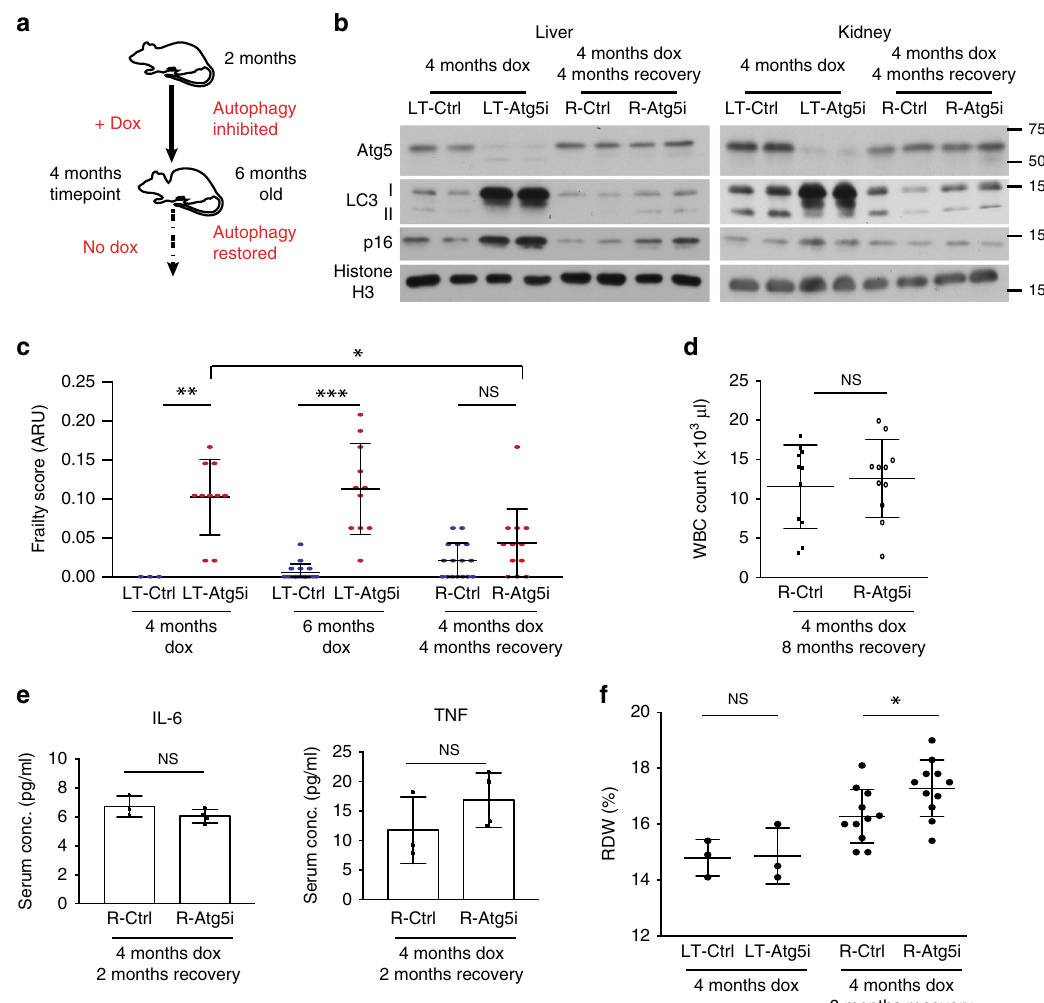
Fig. 4 Restoration of autophagy partially restores health-span. a Schematic of R-Atg5i study. Brie fl y 2-month old mice are given dox to induce Atg5 downregulation for 4 months at which point they exhibit ageing-like phenotypes. Dox is then removed and autophagy restored. b Liver and kidney tissues from R-Atg5i mice with autophagy restored for 4 months display evidence of Atg5 protein and autophagic fl ux restoration, yet the liver still stains positively for the marker of senescence p16. c Atg5i mice on dox for 4 months and 6 months display increase frailty scores in comparison with controls (ARU, arbitrary units). While R-Atg5i mice where autophagy has been restored for 4 months, display a recovery (Two-way ANOVA with Tukey ’ s correction for all comparisons, n = 3 – 16). d Whole blood cell counts from R-Atg5i mice display no difference in comparison with age matched R-Control mice (unpaired two-tailed t test; n = 11 per group). e In fl ammatory serum cytokines IL-6 and TNF are equivalent in R-Atg5i and R-Control mice 2-months post dox removal (Mann Whitney test; n = 3 R-Ctrl and 4 R-Atg5i). f Red blood cell distribution width (RDW) is unaltered in LT-Ctrl and LT-Atg5i cohorts (unpaired two- tailed t test; n = 3 per group), yet appears increased in autophagy-restored cohorts in comparison with age-matched littermate control mice (4 months dox, 8 months restoration) (unpaired two-tailed t test; n = 14 per group). Error bars indicate standard deviation; NS denotes not signi fi cant. * p < 0.05; ** p < 0.01, *** p < 0.001. For b source data are provided as a Source Data fi